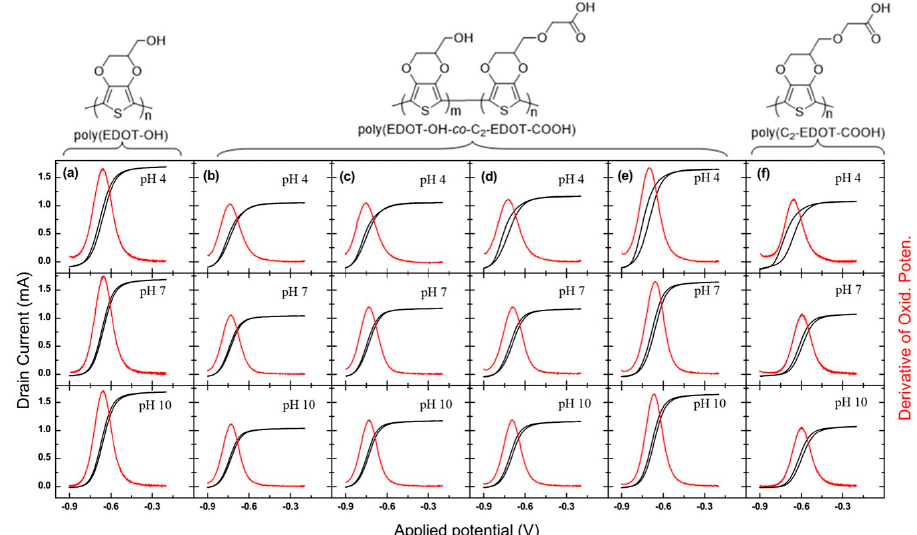
Figure 4. Drain current measurement of ( a ) poly(EDOT-OH) ( b – e ) poly(EDOT-OH- co -C 2 -EDOT-COOH) with monomers ratio (EDOT-OH / C 2 -EDOT-COOH) of 80 / 20, 60 / 40, 40 / 60, and 20 / 80, respectively, ( f ) poly(C 2 -EDOT-COOH). The red lines indicate the first derivative of the oxidation drain current sweep ( E onset ).